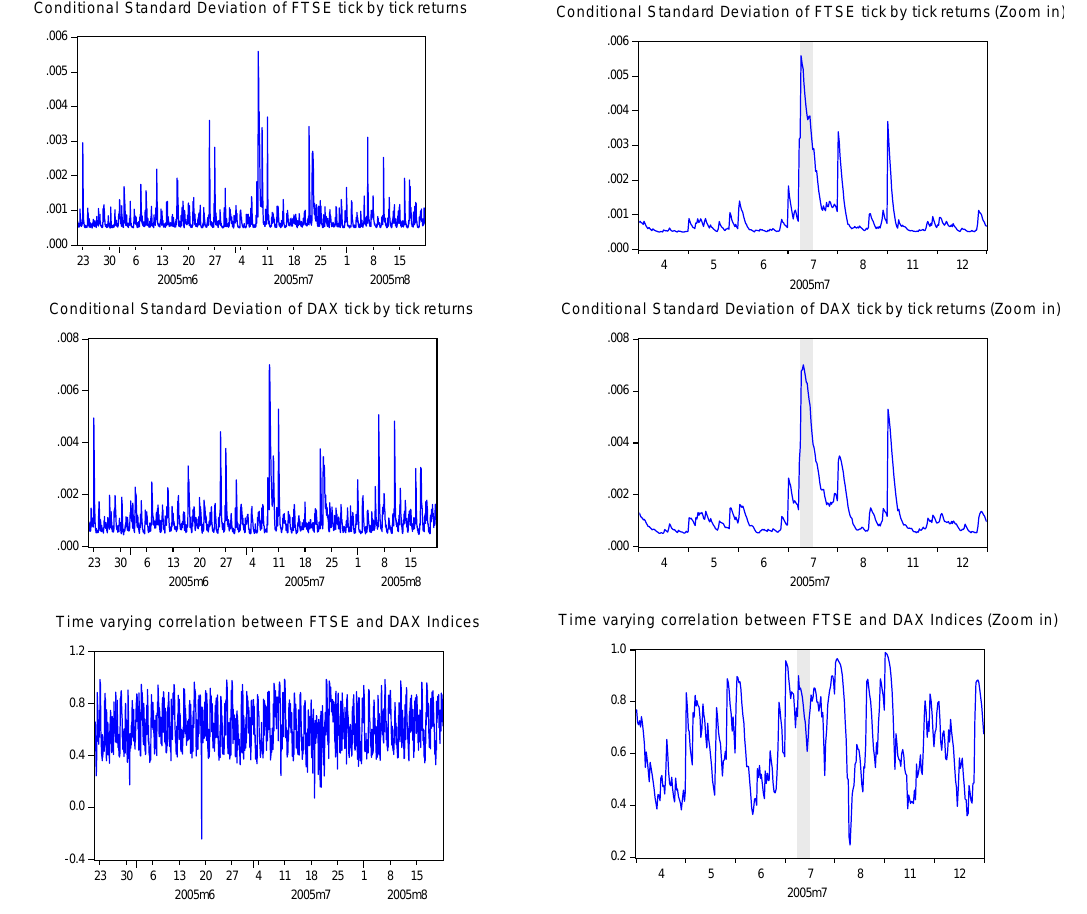
Figure 3. Conditional Volatilities and Correlation for FTSE-DAX intraday stock